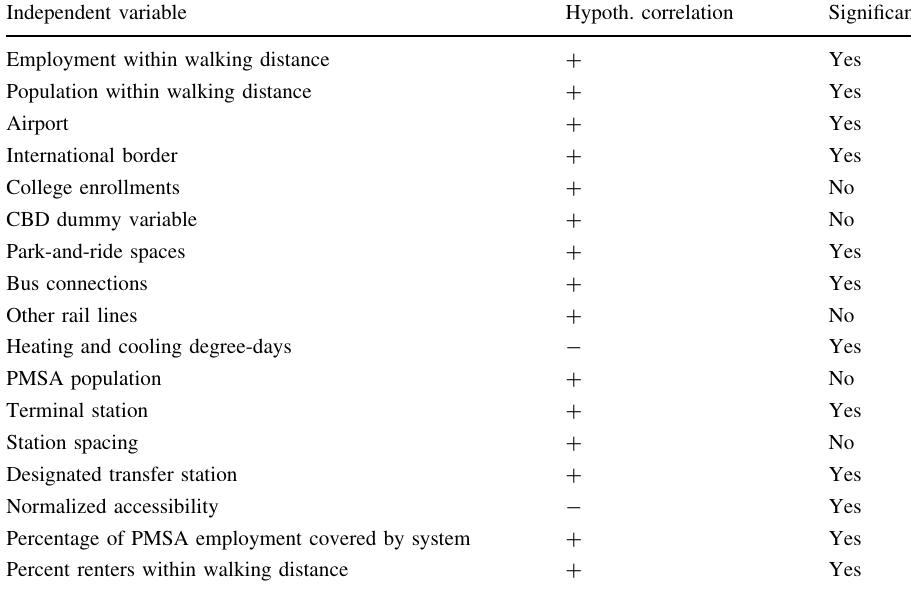
Independent variable Hypoth.